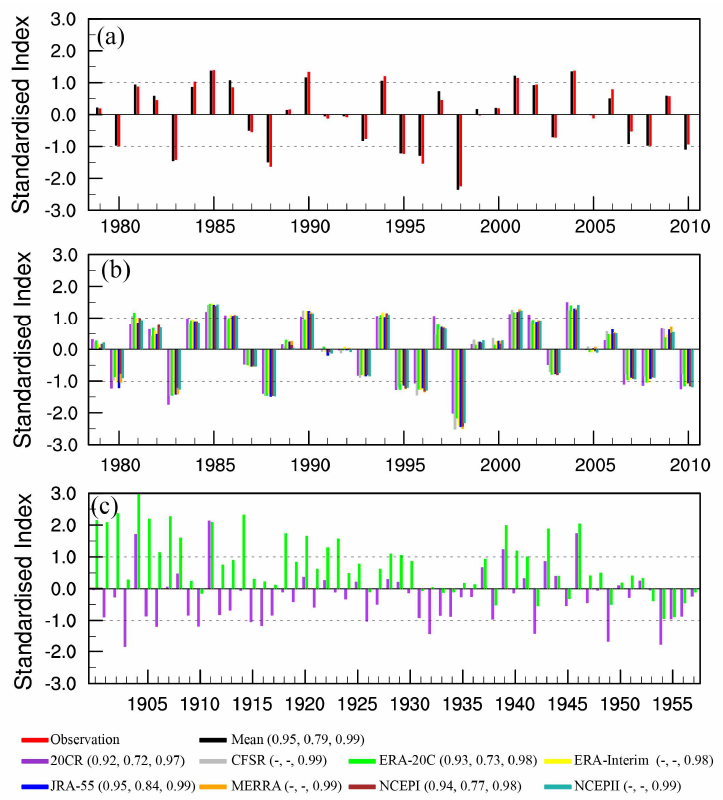
Figure 8. East Asian summer monsoon index of observation (IGRA) and multi-reanalysis ensemble mean ( a ), individual re-analysis dataset ( b ), and the 20CR and ERA-20C in 1900–1957 ( c ). The number following the re-analysis presents the correlation coefficient between the East Asian summer monsoon index produced by re-analysis and the observed one during 1958–2010 (left), during 1958–1978 (middle), and during 1979–2010